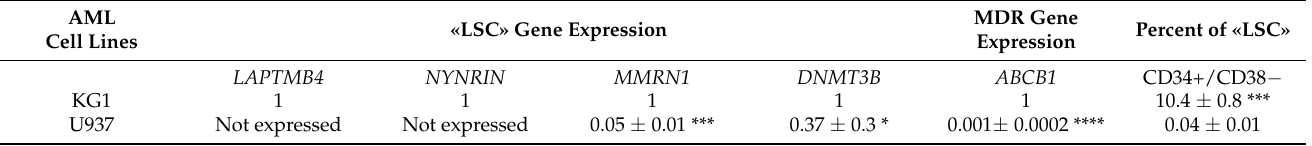
Table 1. Relative expression of LSC genes, ABCB1 and LSC compartment proportion in KG1 and U937 AML cell lines. RT–qPCR was performed to analyze the relative expression of the indicated genes as described in the Materials and Methods section. The percentage of LSCs (CD34 + CD38 − ) was also analyzed by flow cytometry. * p < 0.05; *** p < 0.001; **** p < 0.0001.